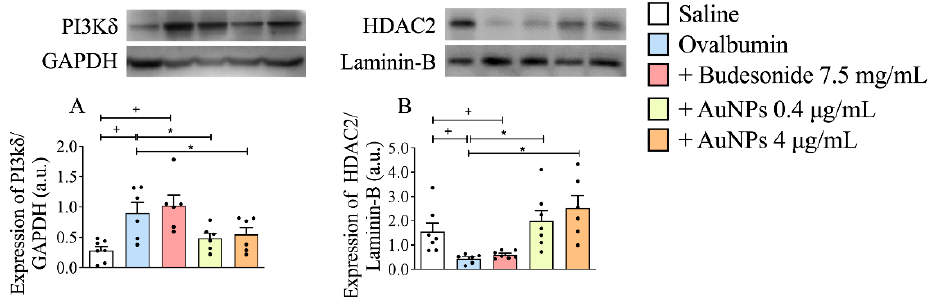
Figure 6. The effect of nebulized Budesonide or gold nanoparticles (AuNPs) on changes in phosphoinositide 3-kinases δ (PI3K δ ) and histone deacetylase 2 (HDAC2) expression in lung tissue samples. The whole-lung extract was analyzed by Western blotting for PI3K δ ( A ), while HDAC2 expression ( B ) was assessed in the nuclear extract of the lung tissue. The intensity of either PI3K δ and HDAC2 expression was quantified by densitometry and presented as relative intensity of glyceraldehyde-3-phosphate dehydrogenase (GAPDH) and Lamin-B, respectively. Data are expressed as mean ± SD ((Each dot represents an individual mouse; n = 6 − 7 for all groups). + p ˂ 0.05 as compared with the saline group, * p ˂ 0.05 as compared with the ovalbumin-challenged group.